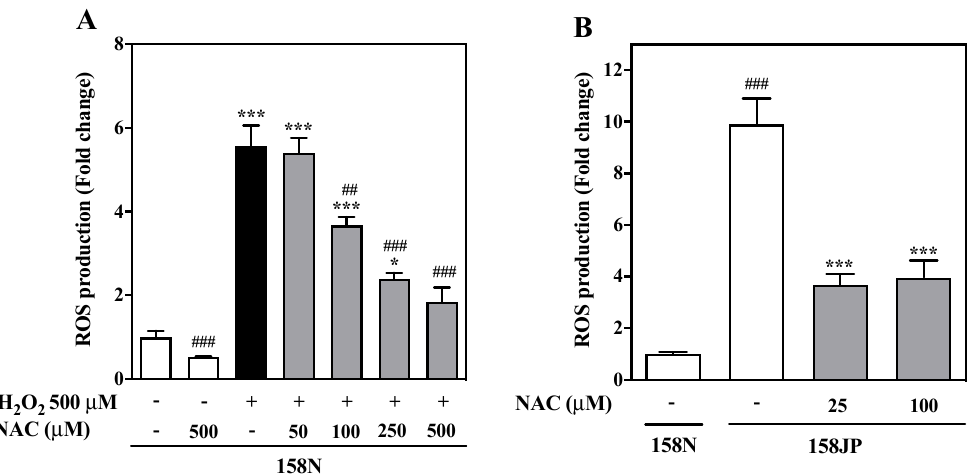
Figure 1. N-acetylcysteine (NAC) decreased reactive oxygen species (ROS) production in oligodendrocytes. ( A ) 158N cells were treated with H 2 O 2 (500 µ M) for 24 h with and without NAC (50 to 500 µ M). ( B ) Untreated control 158N cells and 158JP cells treated with NAC (25 µ M and 100 µ M) for 24 h. The production of ROS was calculated relative to the control 158N cells, and the results were expressed as fold change ( A , B ). The ROS levels were measured using a CM-H 2 DCFDA probe by fluorescence-activated cell sorting (FACS). The data were analyzed by one-way analysis of variance (ANOVA) with Tukey’s post-hoc test. *** p < 0.001 and * p < 0.05 indicate significance between control and treated groups ( A , B ). ### p < 0.001 and ## p < 0.01 show significance comparing ( A ) H 2 O 2 alone to NAC treatment groups, and ( B ) baseline ROS levels between 158N and 158JP lines.